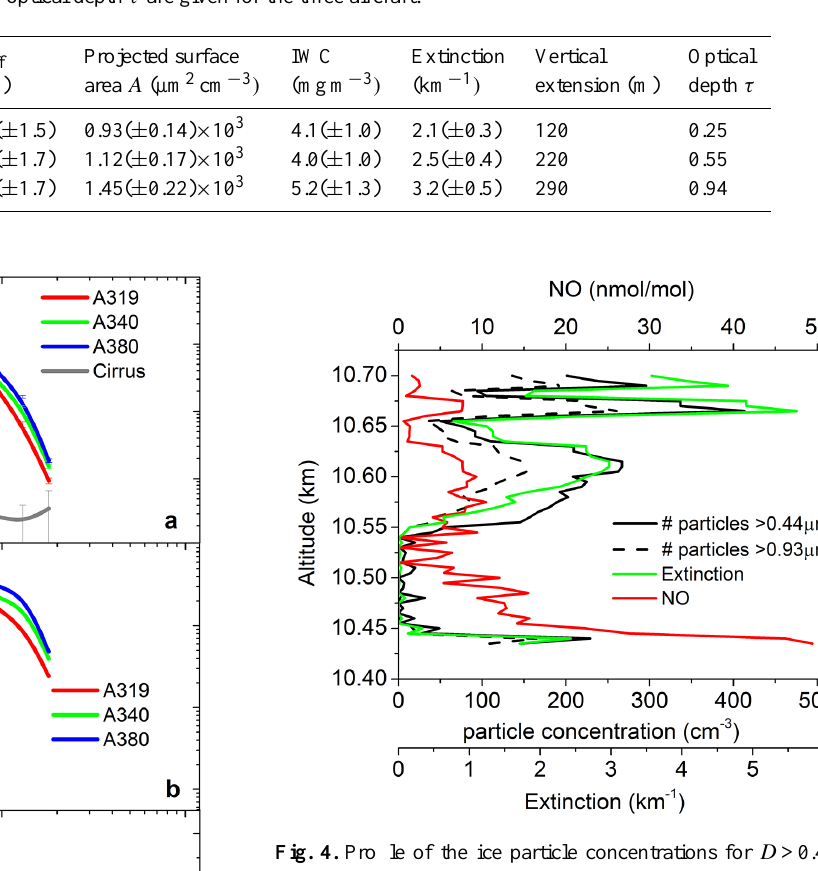
Fig. 4. Profile of the ice particle concentrations for D >0.44 and D >0.93µm, extinction derived from FSSP data and NO levels in the A380 aircraft case versus altitude. The profile has been recorded in the time between 44223s and 44327s UTC (see Fig. 2, bottom panel) at a mean contrail age of 108s. Enhanced particle concen- trations and NO mixing ratios are observed over a vertical range of 270m. The primary vortex has been entered at altitudes below 10.45km. It may extend further